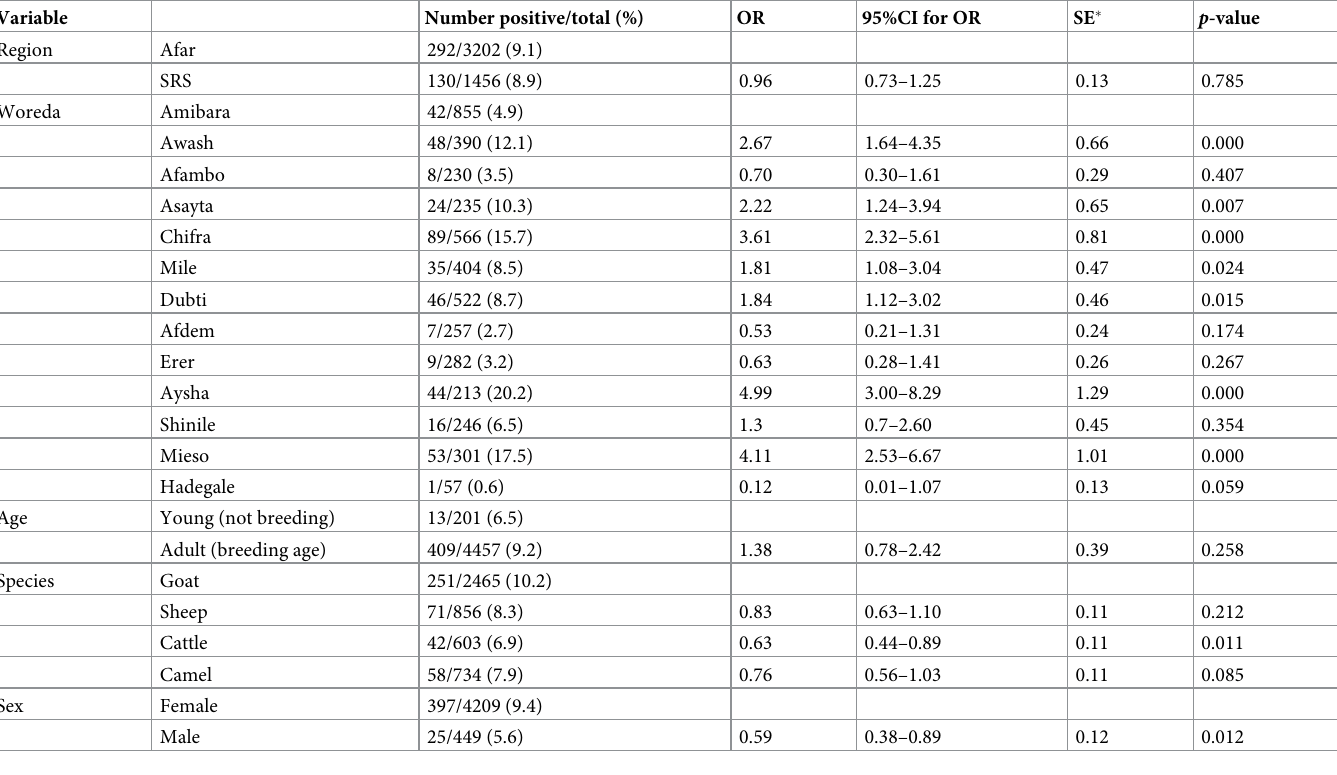
Table 6. Univariate analysis in livestock with random effect on household/herd level (GEE model).